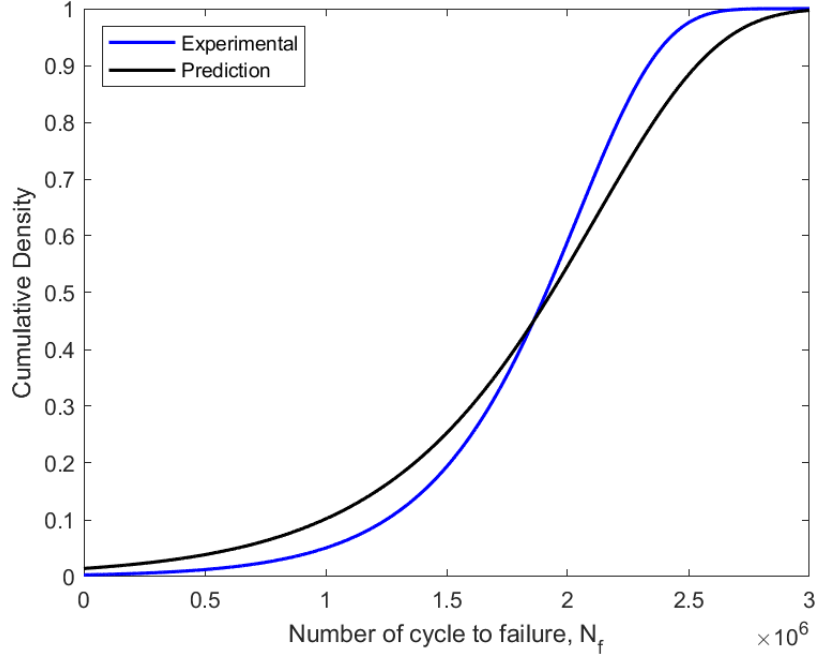
Figure 14. Weibull distribution CDF fitted using experimental and predicted data on fatigue.